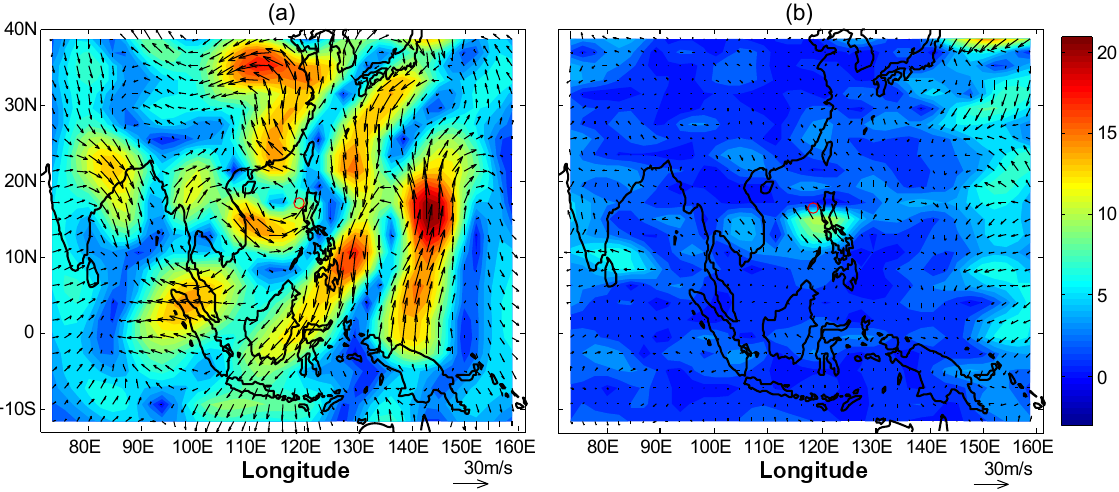
Figure 7. Biases of large-scale wind fields at 200 hPa for experiments ( a ) CTL and ( b ) GFS-DA against those in GFS analysis valid at 1200 UTC 19 Oct 2010 (right after the SSDA implementation; unit: m s − 1 ). TC locations are indicated in red circles.